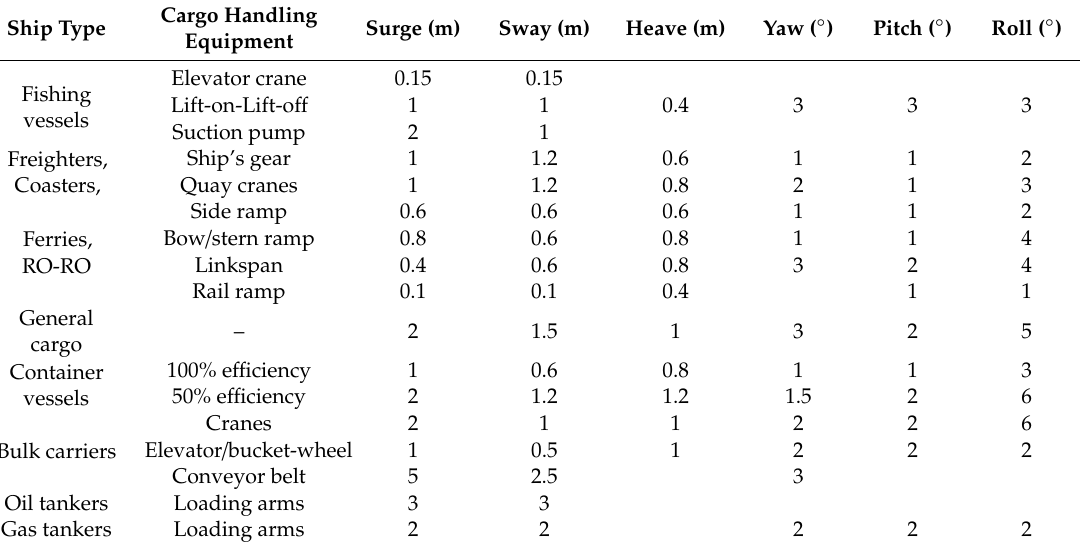
Table 1. Recommended motion criteria for safe working conditions